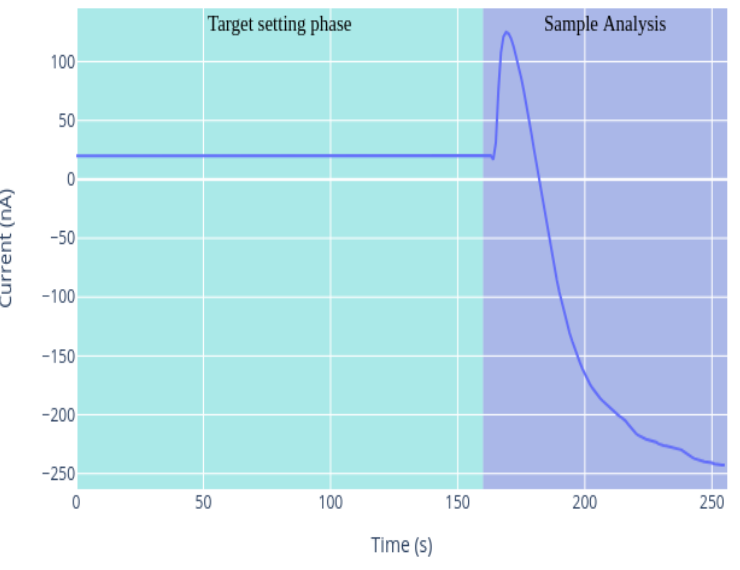
Figure 6. Different phases during sample